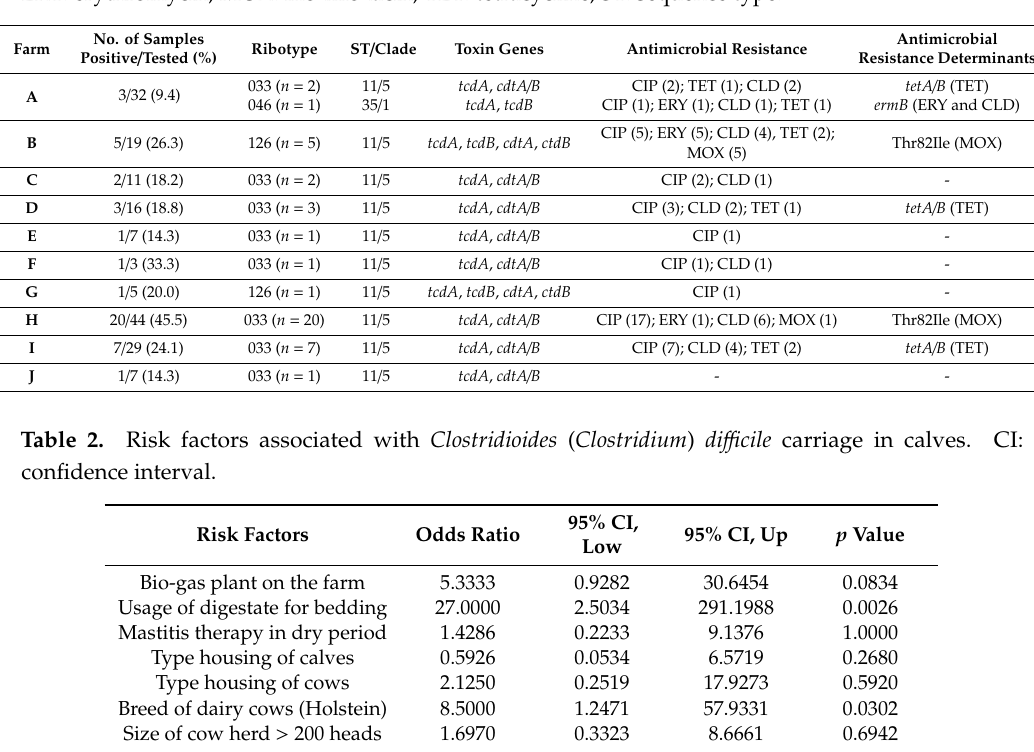
Table 1. The characterisation of C. di ffi cile isolates in the study. CLD: clindamycin; CIP: ciprofloxacin; ERY: erythromycin; MOX: moxifloxacin; TET: tetracycline; ST: sequence type.